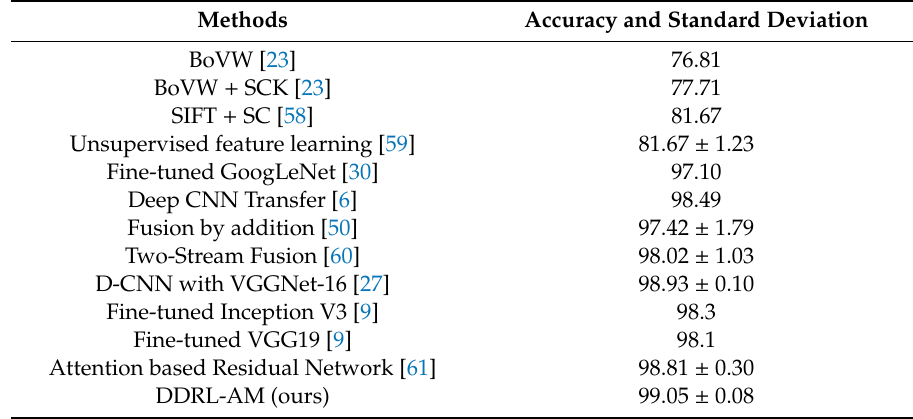
Table 2. Scene classification results (ac% ± std) using the UC merced dataset with 80% training ratio.